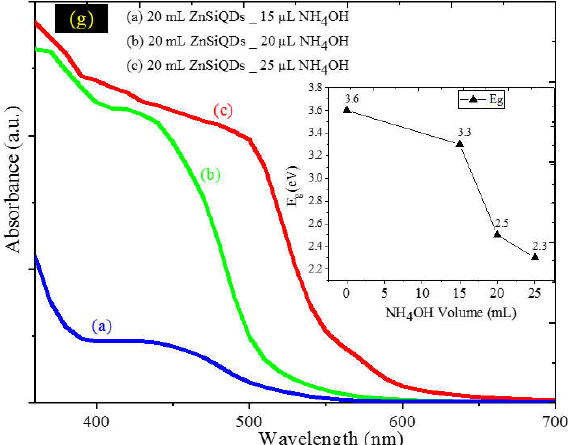
Figure 2. FESEM image of the ZnPSi etched at 5 mA/cm 2 together with emission spectra in ( a ) and XRD pattern in ( b ). EFTEM images of ZnSiQDs suspended in NH 4 OH of volume ( c ) 0, ( d ) 15 ( e ) 20 and ( f ) 25 μL. Greenish-yellow curves show the corresponding particles size distribution, and the blue profile is the Gaussian fit. ( g ) The absorbance of ZnSiQDs suspended in NH 4 OH of volume ( a ) 15, ( b ) 20, and ( c ) 25 μL.